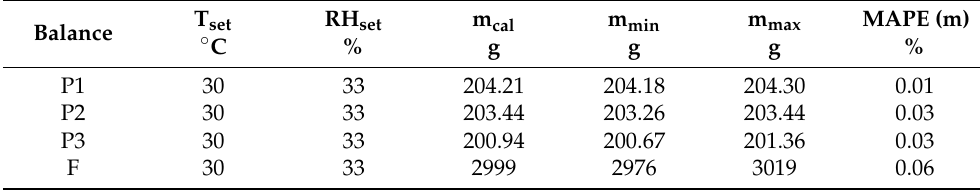
Table 3. Parameters during calibration of the electronic balances in the HPD TP3+.